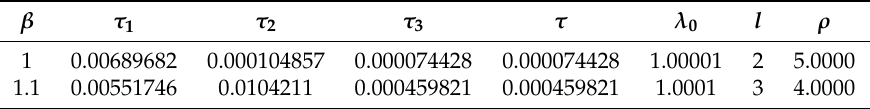
Table 7. Different radii of convergence for Example